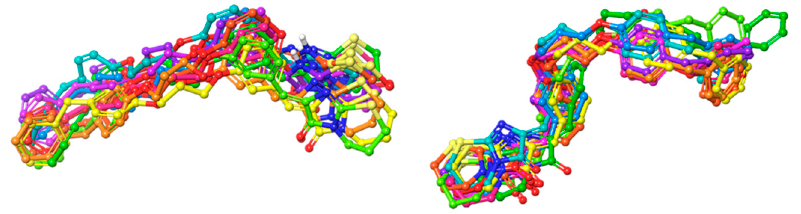
Figure 13. Examination of CB153 standard pose ( left ) and “inverted” ( right ) stability in the binding pocket of the PF-DM model. Compound poses were captured at following frames: 0 ns—green; 1 ns—teal; 2 ns—blue; 3 ns—violet; 4 ns—magenta; 5 ns—pink; 6 ns—red; 7 ns—orange; 8 ns—light orange; 9 ns—yellow; 10 ns—lime. For a colored figure, please refer to the online version of this